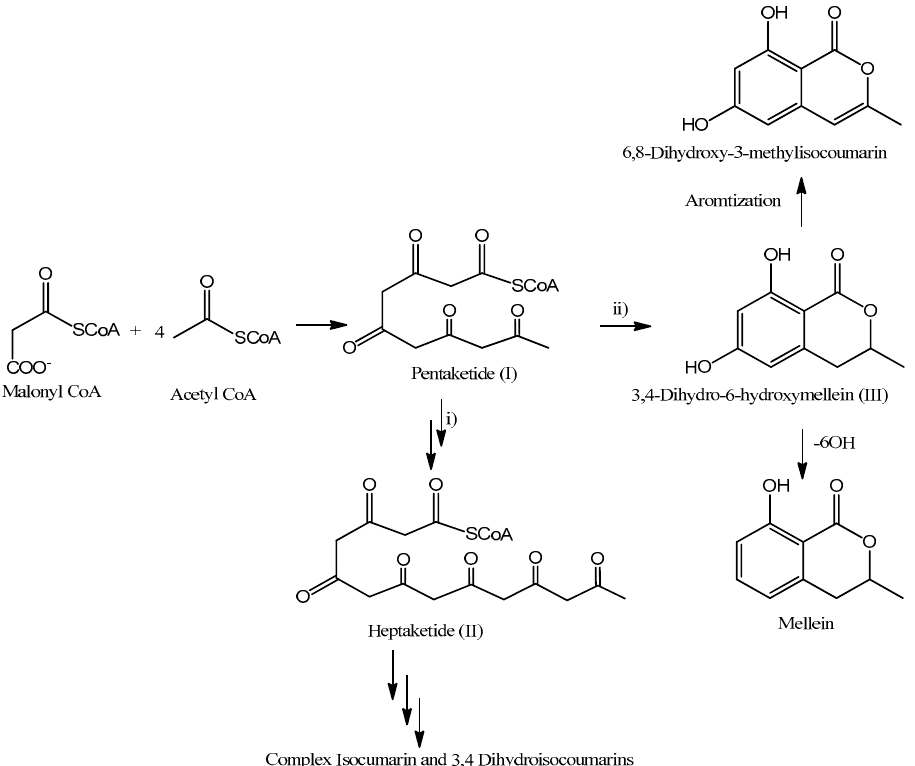
Figure 4. Possible reactions involved with isocoumarines, 3,4-dihydroisocoumarins and melleins biosyntheses.